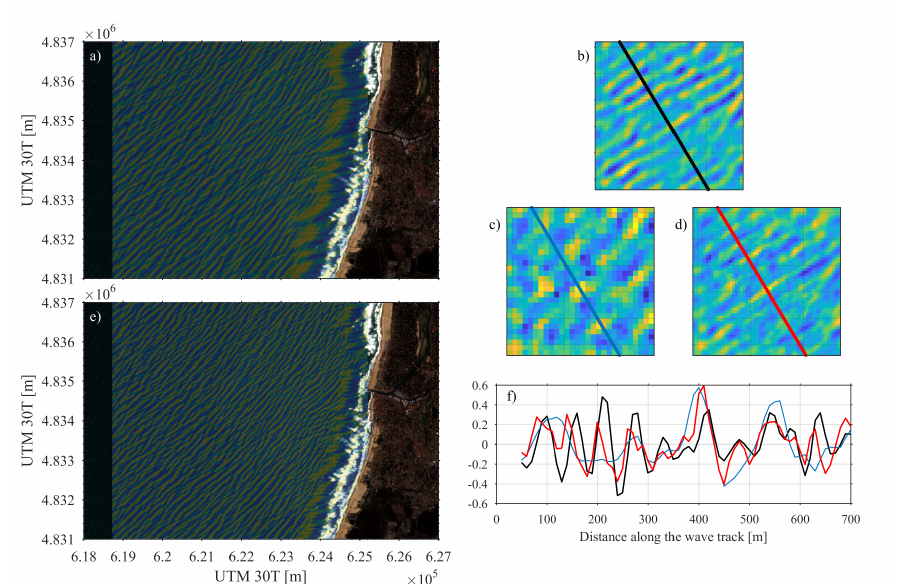
Figure 12. Augmentation of Sentinel-2’ mid-resolution bands (20 m) to the high-resolution (10 m). ( a ) shows the sensed 20 m resolution wave pattern (normalized) derived from detector-band 5 and ( e ) shows the augmented wave pattern (normalized) using a localized Radon transform and interpolation of the local Radon-sinogram. ( b – d , f ) show the effect on the obtained wave signal. ( b ) is a subsample of the B02 band (10 m resolution), ( c ) represents the sensed subsample of band B05 (20 m resolution) and ( d ) is the radon-augmented version (10 m resolution). ( f ) presents the spatial wave-signal along wave-track following the color-coding as in ( b – d